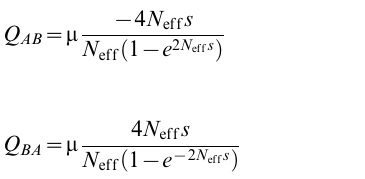
Table S1 Sites identified as undergoing changes in selective